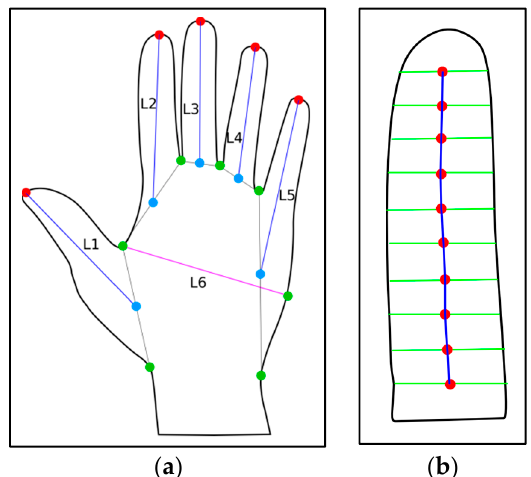
Figure 2. Depiction of measured biometric characteristics [9], where at ( a ) graphics shows the measurable characteristics of the palm of the hand and ( b ) described the base as the point of intersection of green lines.